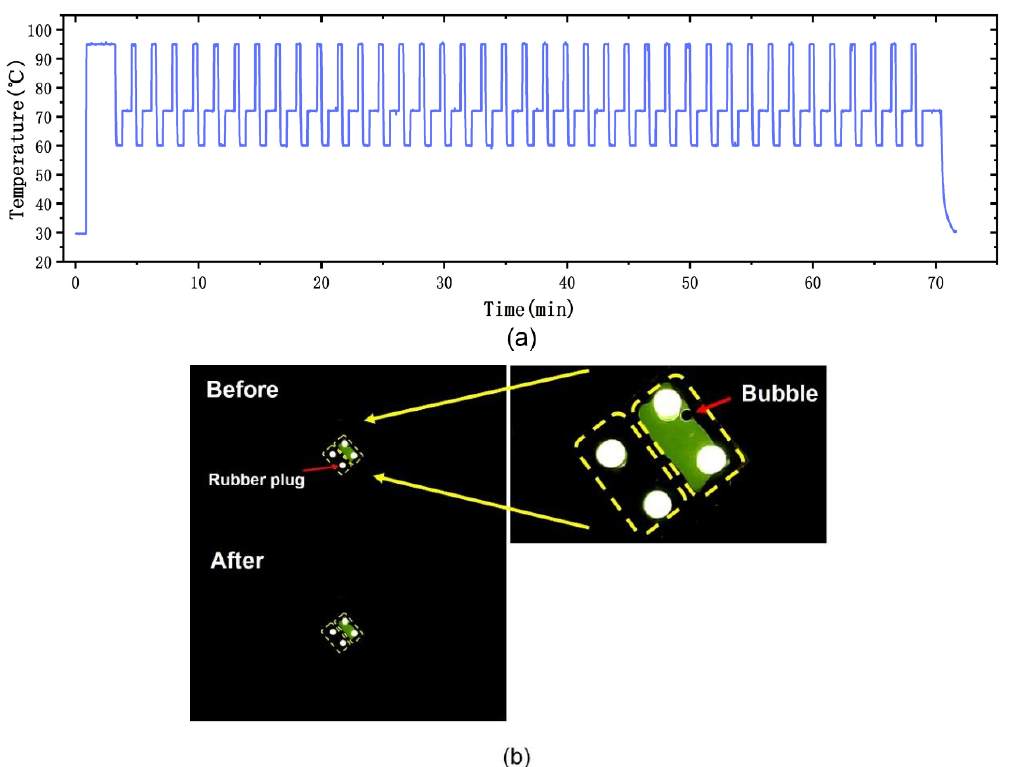
Figure 10. Performance test for the PCR reaction chip and the fluorescence detection system. ( a ) The temperature trace of the PCR protocol. ( b ) PCR reaction chip before and after conventional PCR protocol. Bubbles were sometimes generated when the reagents were injected to the reaction chip using a pipette. The enlarged picture of the PCR reaction chip showed the generated bubble.